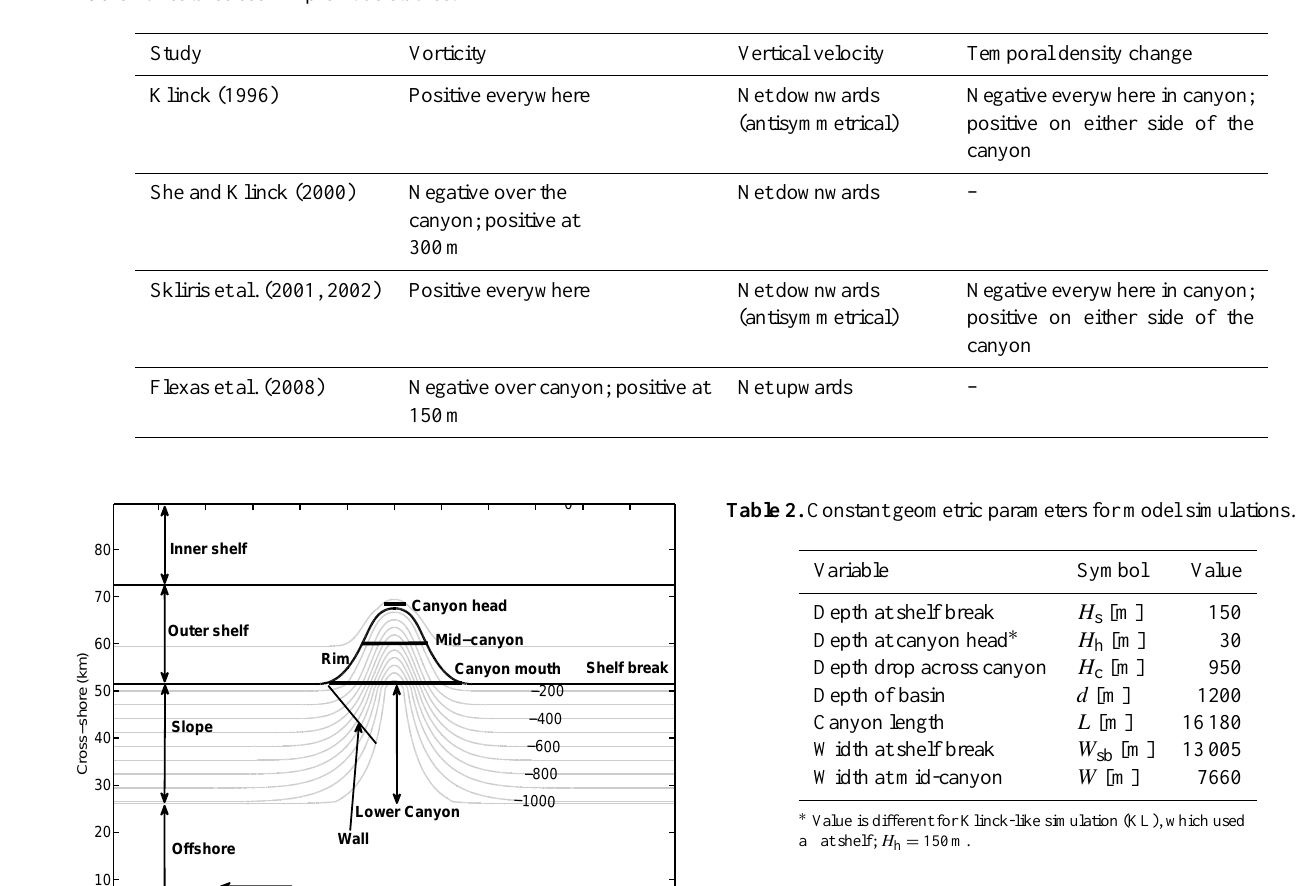
Table 1. Features seen in previous studies.